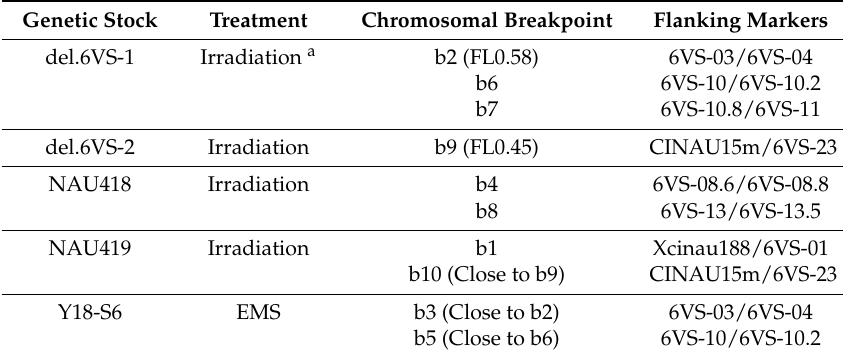
Figure 2. A physical map of 6VS. The breakpoints are shown in the left, and the 6VS-specific DNA markers are shown in the right. The order of the markers is according to the genomic locations of their corresponding orthologous genes in Brachypodium . The red box carries Pm21 . Table 1. Chromosomal breakpoints (b1–b10) in different genetic